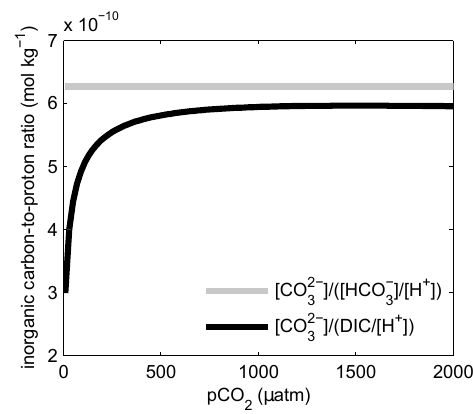
Figure 3. Ratio of [CO 2 − ] and [HCO − ] / [H + ] compared to the 3 3 ratio of [CO 2 − ] and DIC / [H + ]. [CO 2 − ]/([HCO − ] / [H + ]) is con- 3 3 3 stant, since CO 2 − and [HCO − ] / [H + ] are proportional to each 3 3 other under constant temperature, salinity, and pressure (Eq. 9). In contrast, the correlation between [CO 2 − ] and DIC/[ H + ] only 3 works well when the majority of DIC is found in the HCO − pool. 3 This is the case for p CO 2 values larger than ∼ 250–500µatm, where [CO 2 − ] / (DIC / [ H + ]) shows very little change. Below this thresh- 3 old, however, the correlation starts deviating from linearity since an exponentially increasing proportion of the DIC pool is present as CO 2 − 3